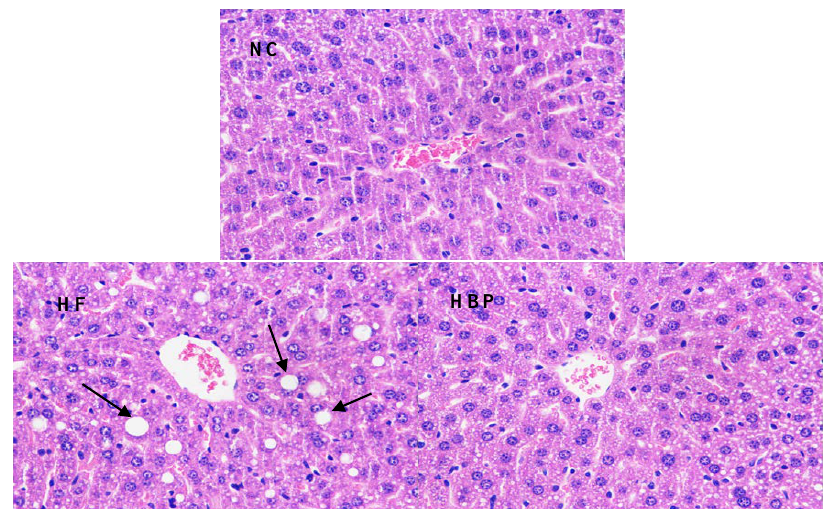
Figure 1. Representative microphotographs of liver tissue sections of C57BL/6J mice in NC, HF, and HBP groups (H&E staining × 200) (NC, normal control group; HF, high-fat-diet fed group; HBP, high-fat-diet fed group treated with hydrolyzed bound phenolics, the same